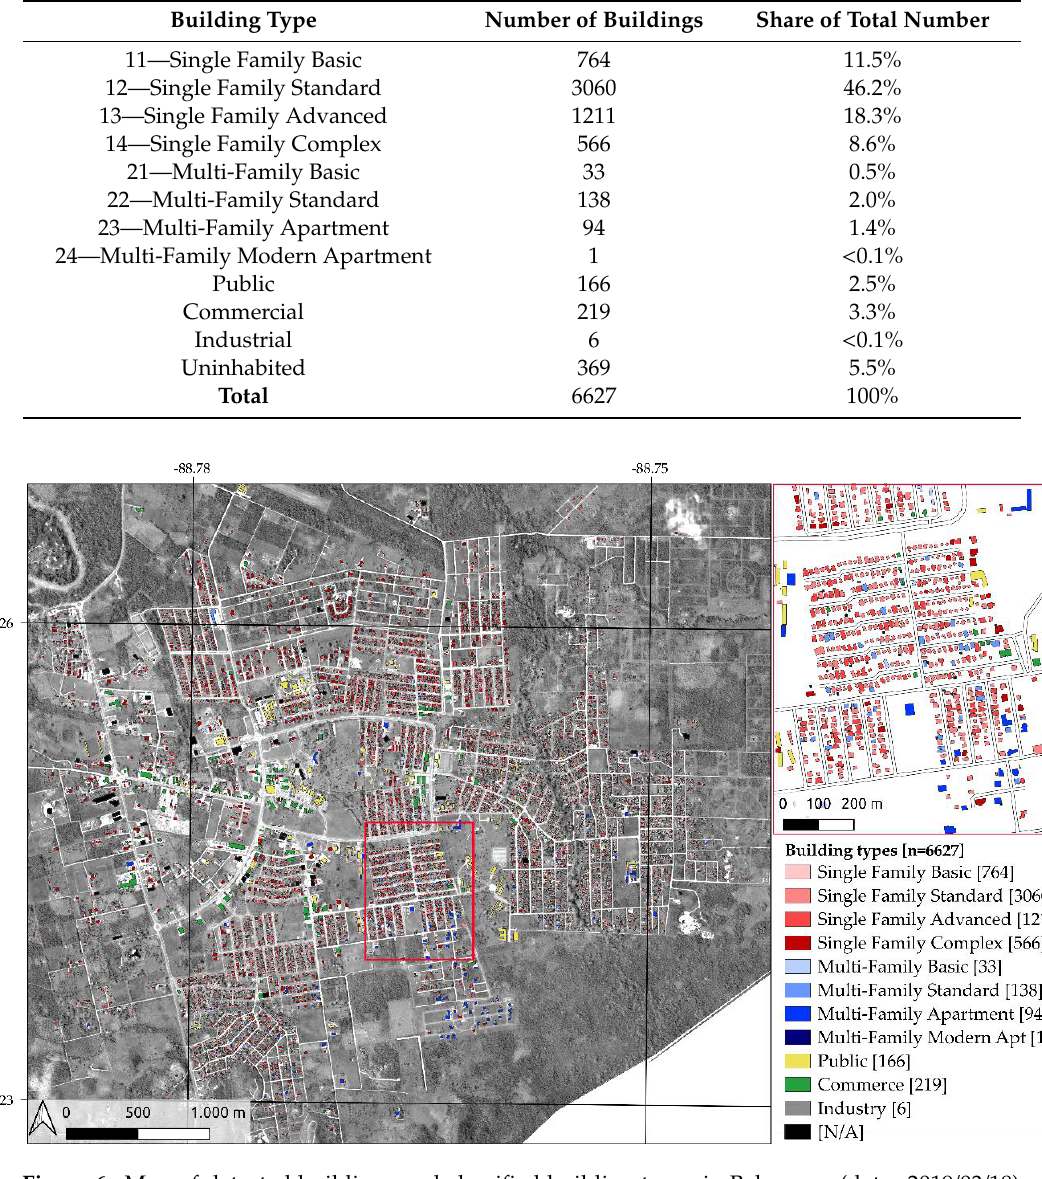
Table 6. Building type information in Belmopan.